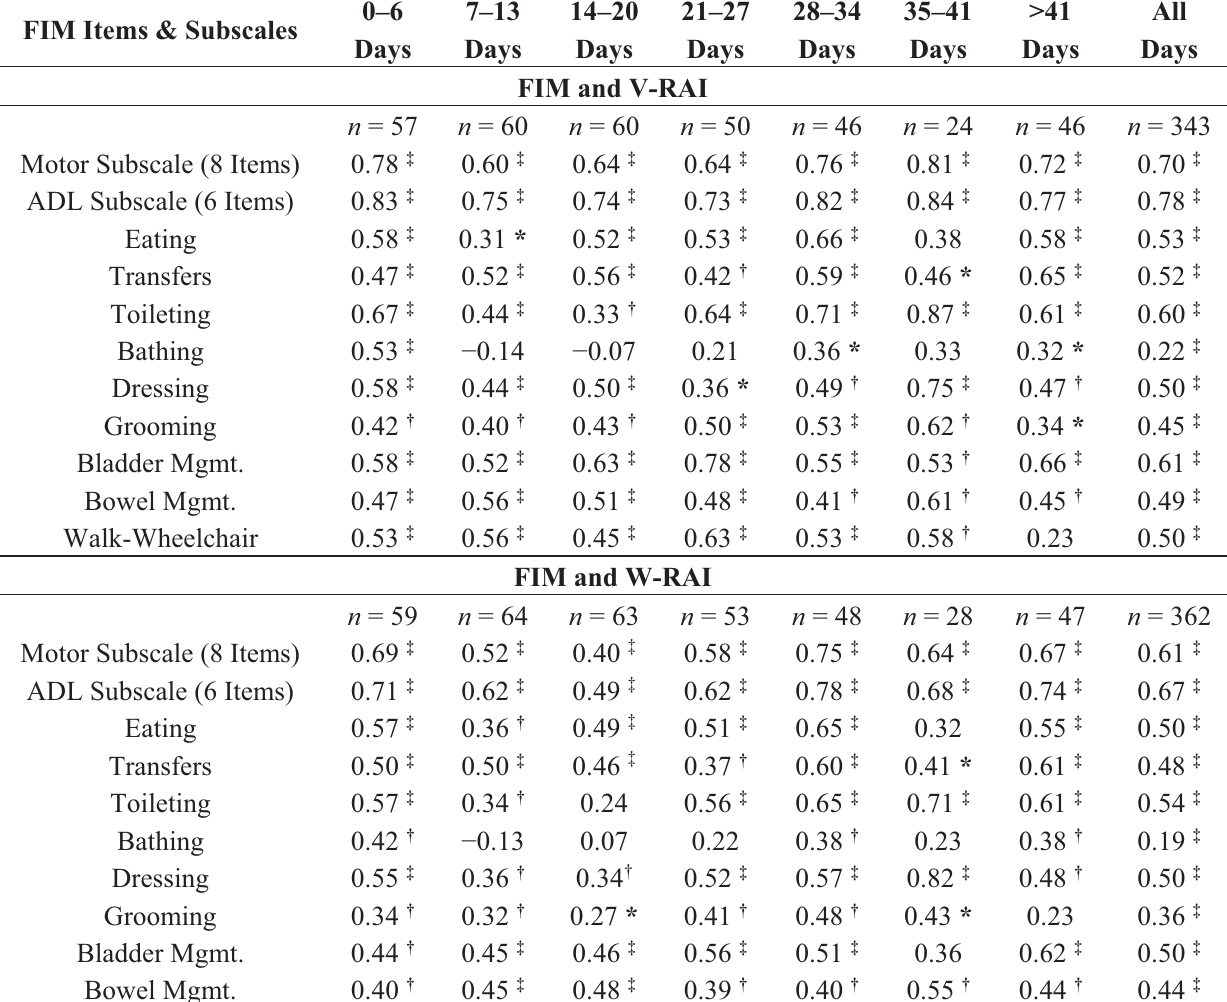
Table 2. Pearson’s correlation coefficients for comparisons between FIM and V-RAI assessments, and FIM and W-RAI assessments by time intervals between the